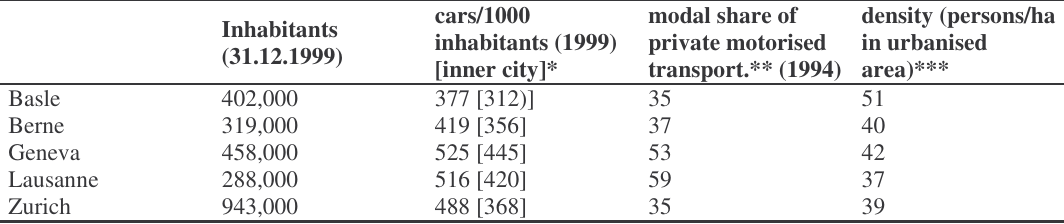
Table 1. Key factors for urban transport in five Swiss